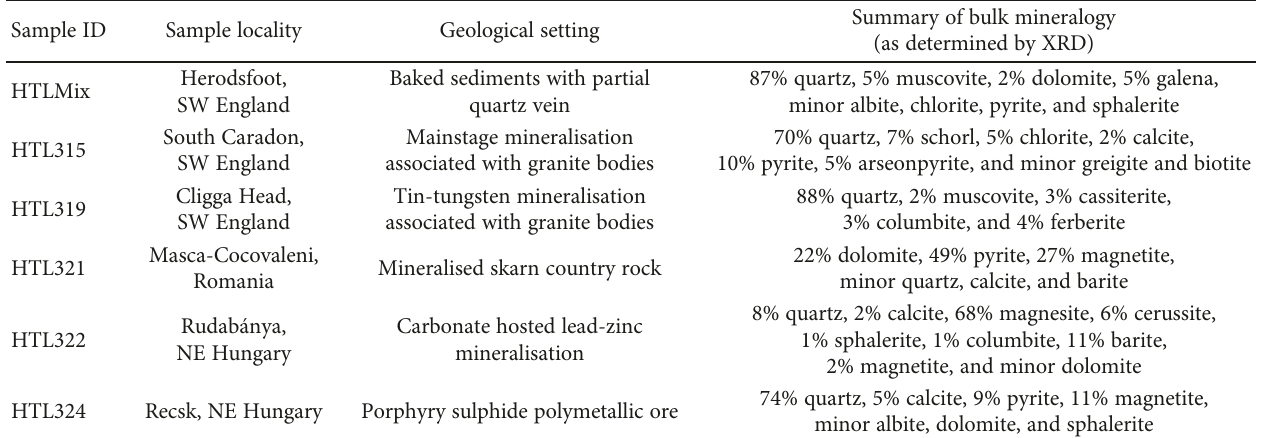
Table 1: Major geological and mineral properties of the